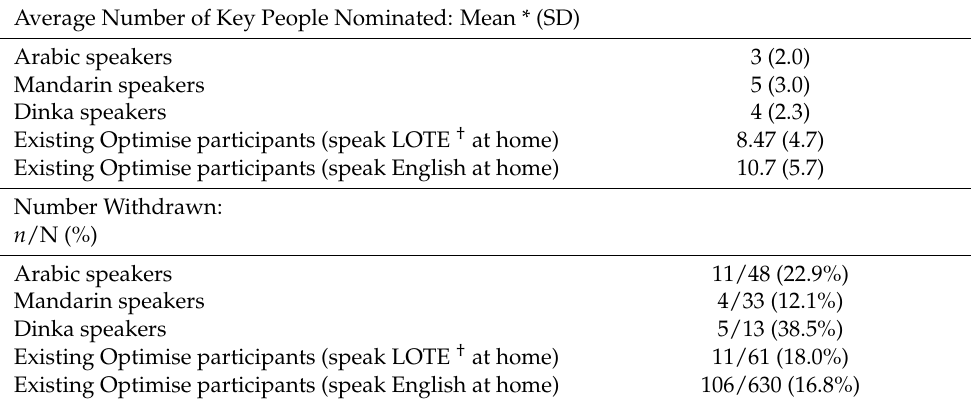
Table 2. Survey participation of new versus existing CALD participants.